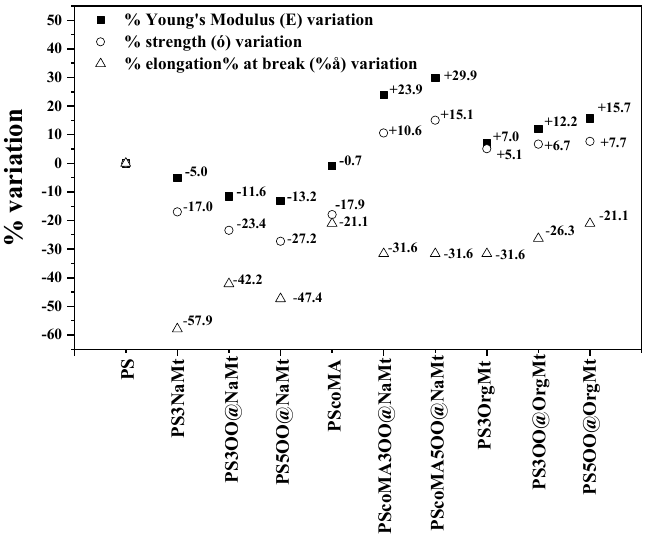
Figure 4. %Variation of Young’s Modulus-E values, tensile strength ( σ ) values, and %elongation at Figure 4. % Variation of Young’s Modulus- E values, tensile strength ( σ ) values, and %elongation the break-% ε values for all tested PS based active packaging at the break - % ε values for all tested PS based active packaging films.